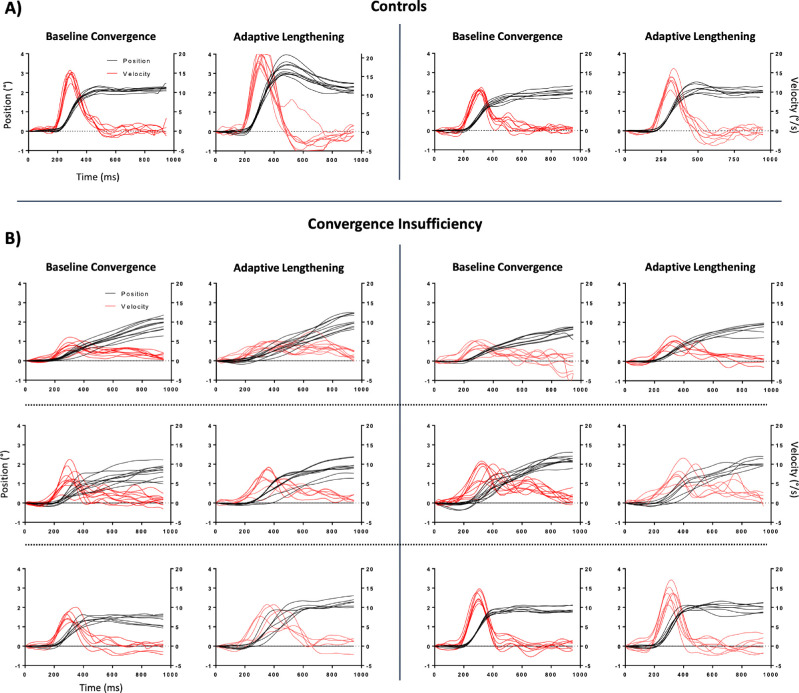
Convergence response amplitude (black) and velocity (red) traces for two BNC participants (A) and six CI participants (B). Baseline convergence plots are the last block of 10 responses in the baseline phase. Adaptive lengthening plots are the vergence responses to the test stimuli during the adaptation phase. The subject plots in the middle-left rows of (B) show an example of one of the CI participants who was unable to fuse the convergence step stimuli during the latter portions of the adaptation phase.